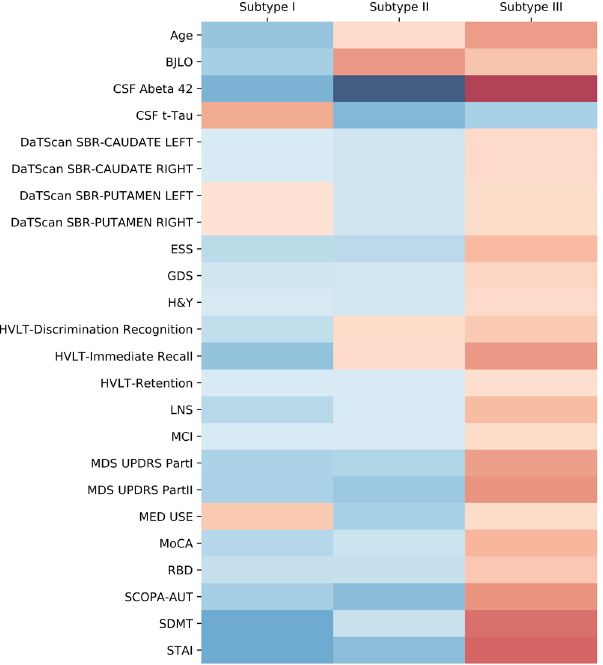
Figure 3. Heatmap illustration of the patient subtyping results of LSTM for three subtypes. The colors are generated according to mean values of subtypes. The red color depicts more a severe deficit for the variable and the blue color means that the symptom is less severe. The darker color represents larger difference with total average. Variables with p-value < 0.05 are shown.